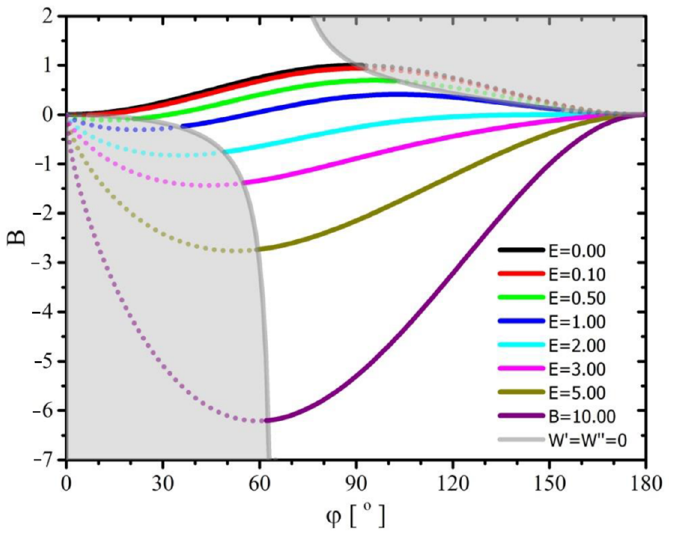
Figure 5. Dependence of the B = σ FI parameter on the contact angle for several values of the E = ε R π σ CI parameter—the equilibrium of forces acting on the droplet. The gray area marks solutions to the unstable equilibrium of forces.